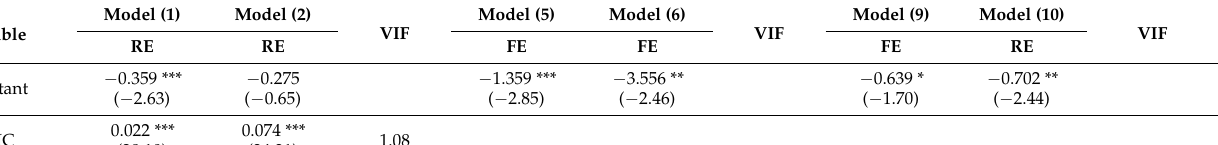
Table 8. Regression results of Models (1), (2), (5), (6), (9), and